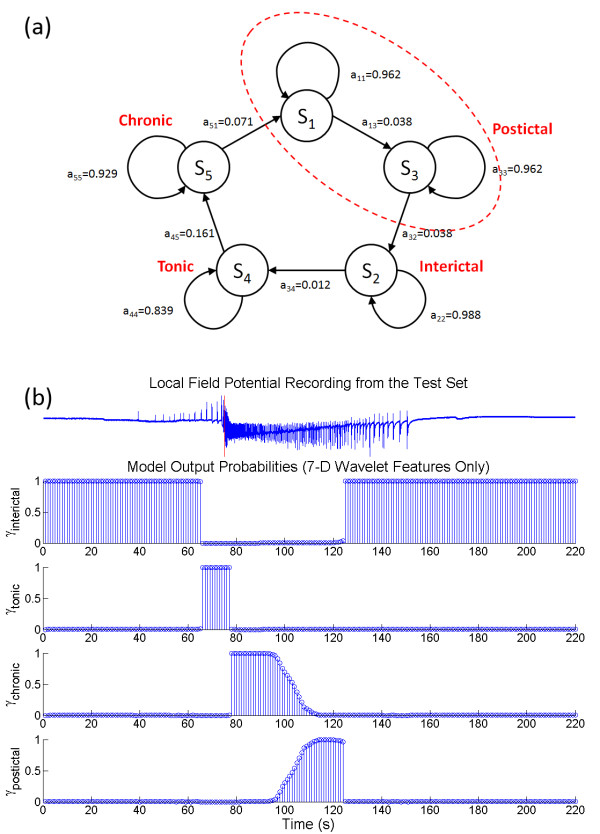
The transition diagram and the posterior probabilities for HMMopt7D using the original feature space. (a) A unidirectional sequence of state progress was found for the HMMopt7D. Even though the validation result indicated that a five state model should be used, S1 and S5 can be consolidated to represent the postictal events after expert guided state assignment. (b) The mapping of HMMopt7D output to the electrophysiological data is given. The marginal posterior probabilities illustrate that the HMMopt7D is able to detect the non-ictal, tonic firing, chronic seizures and postictal activities.